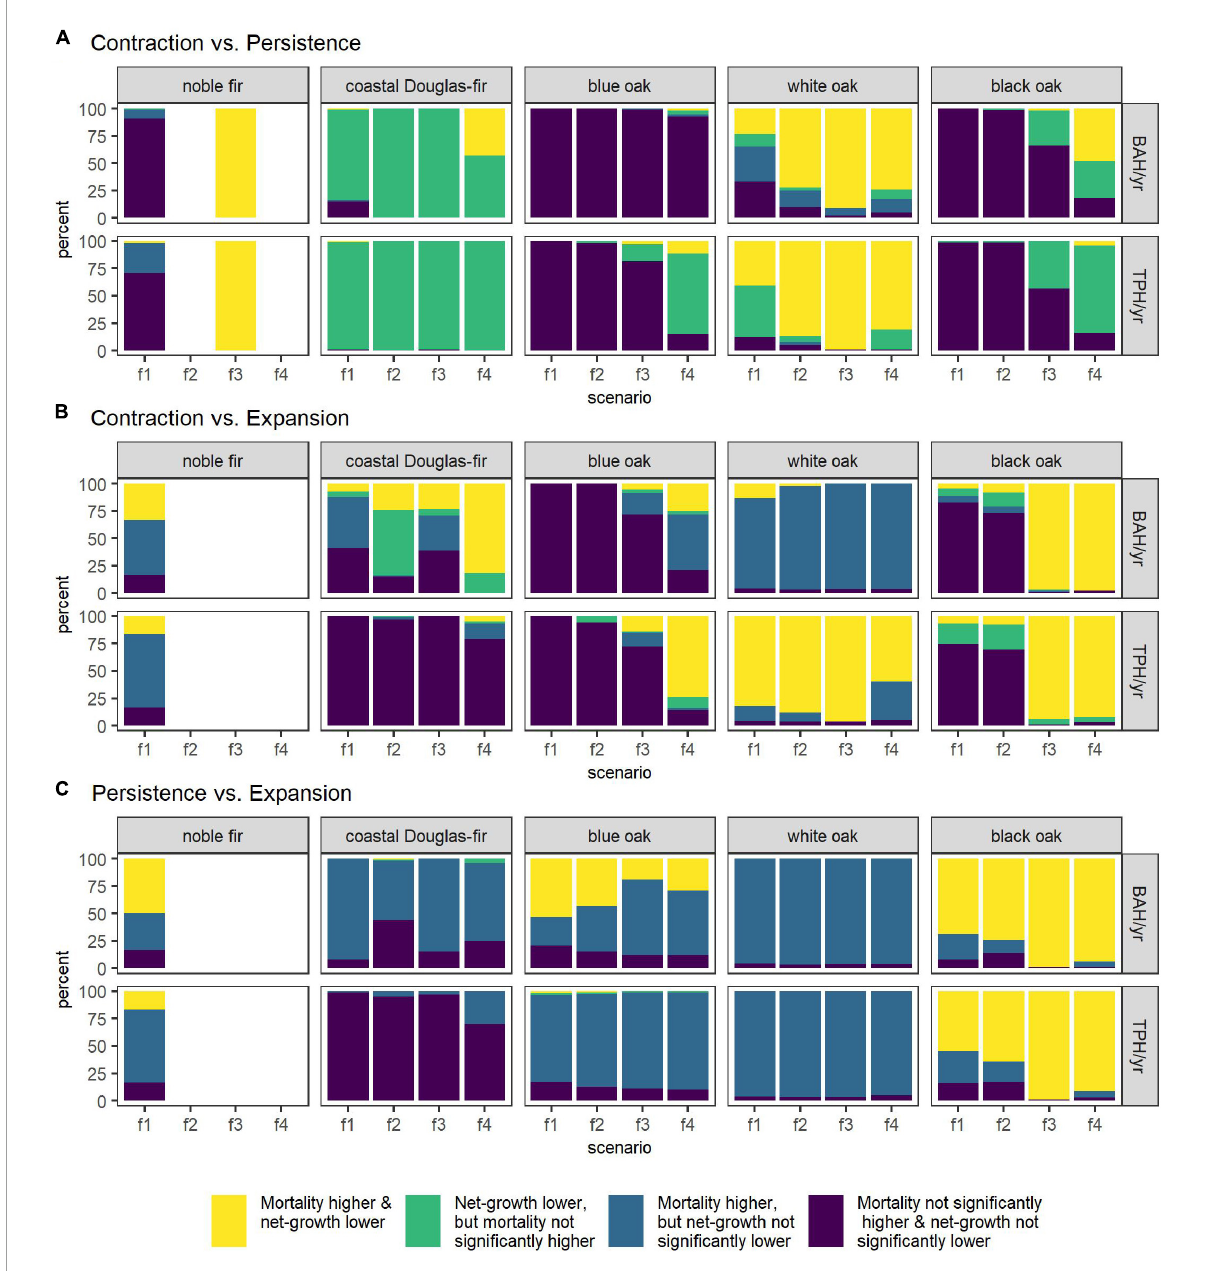
FIGURE5 The percent-agreement between PECA-divisions’ estimates across MCMC samples by species (column) and future climate scenario (x-axis) based on two one-tailed z-tests (0.1-level): one for higher mortality and one for lower net-growth in areas of contraction than persistence (A) , contraction than expansion (B) , and persistence than expansion (C) . Results are shown for BAH/year and TPH/year estimates of mortality and net-growth on forest land where the species was present. Future climate scenarios are coded by increasing severity as: RCP 4.5 CCSM4 (f1; mildest scenario), RCP 4.5 HadGEM2-ES (f2), RCP 8.5 CCSM4 (f3), and RCP 8.5 HadGEM2-ES